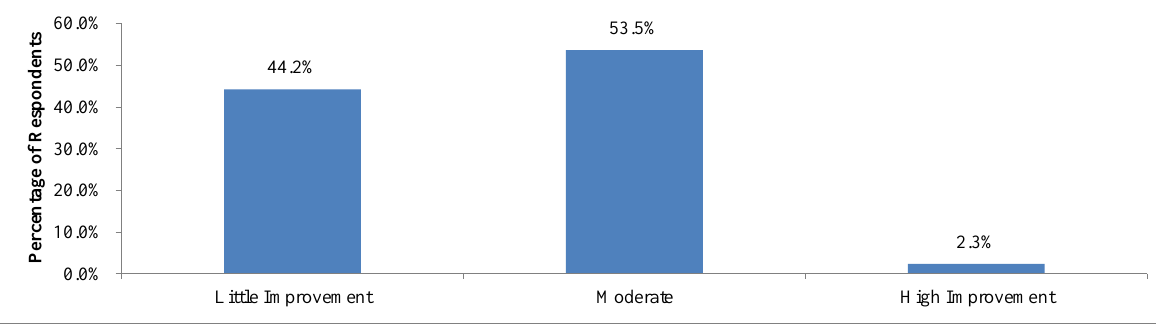
Figure 3: Respondents view of Efficiency Improvement by TKNB Employees